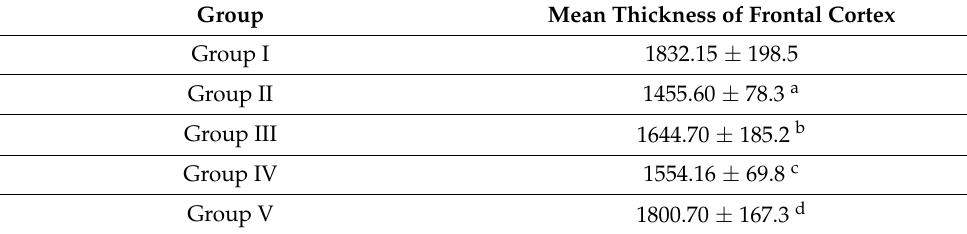
Table 2. Effect of alcohol and/or ATOR on mean thickness of frontal cortex and assessment of ASA treatment (mean ± SD).